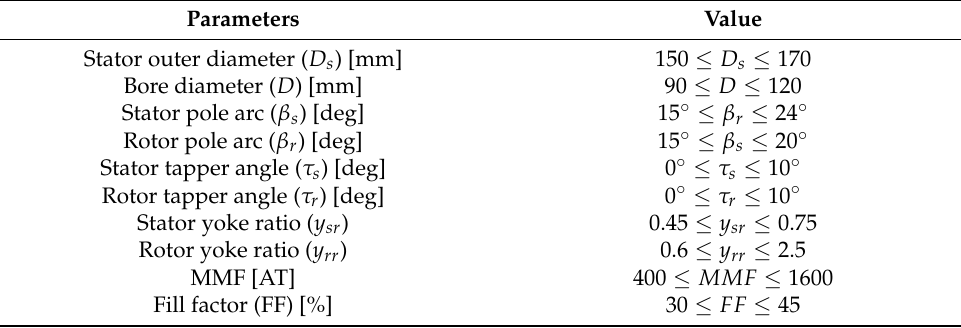
Table 3. Motor parameters for